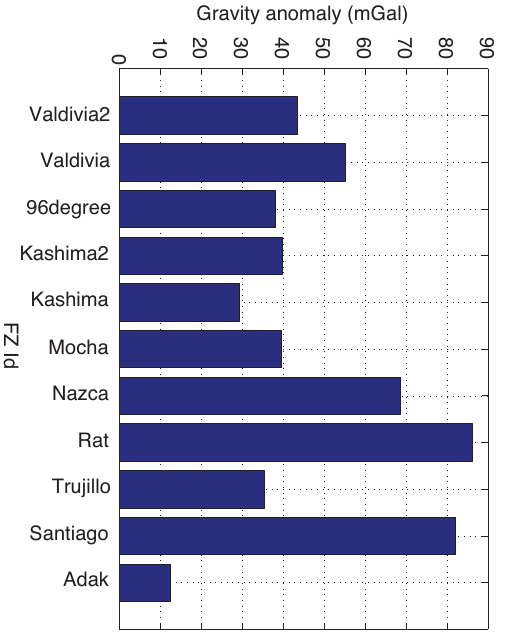
Fig. E1. Gravity anomalies associated with the fracture zones cor- responding to those shown in Fig.